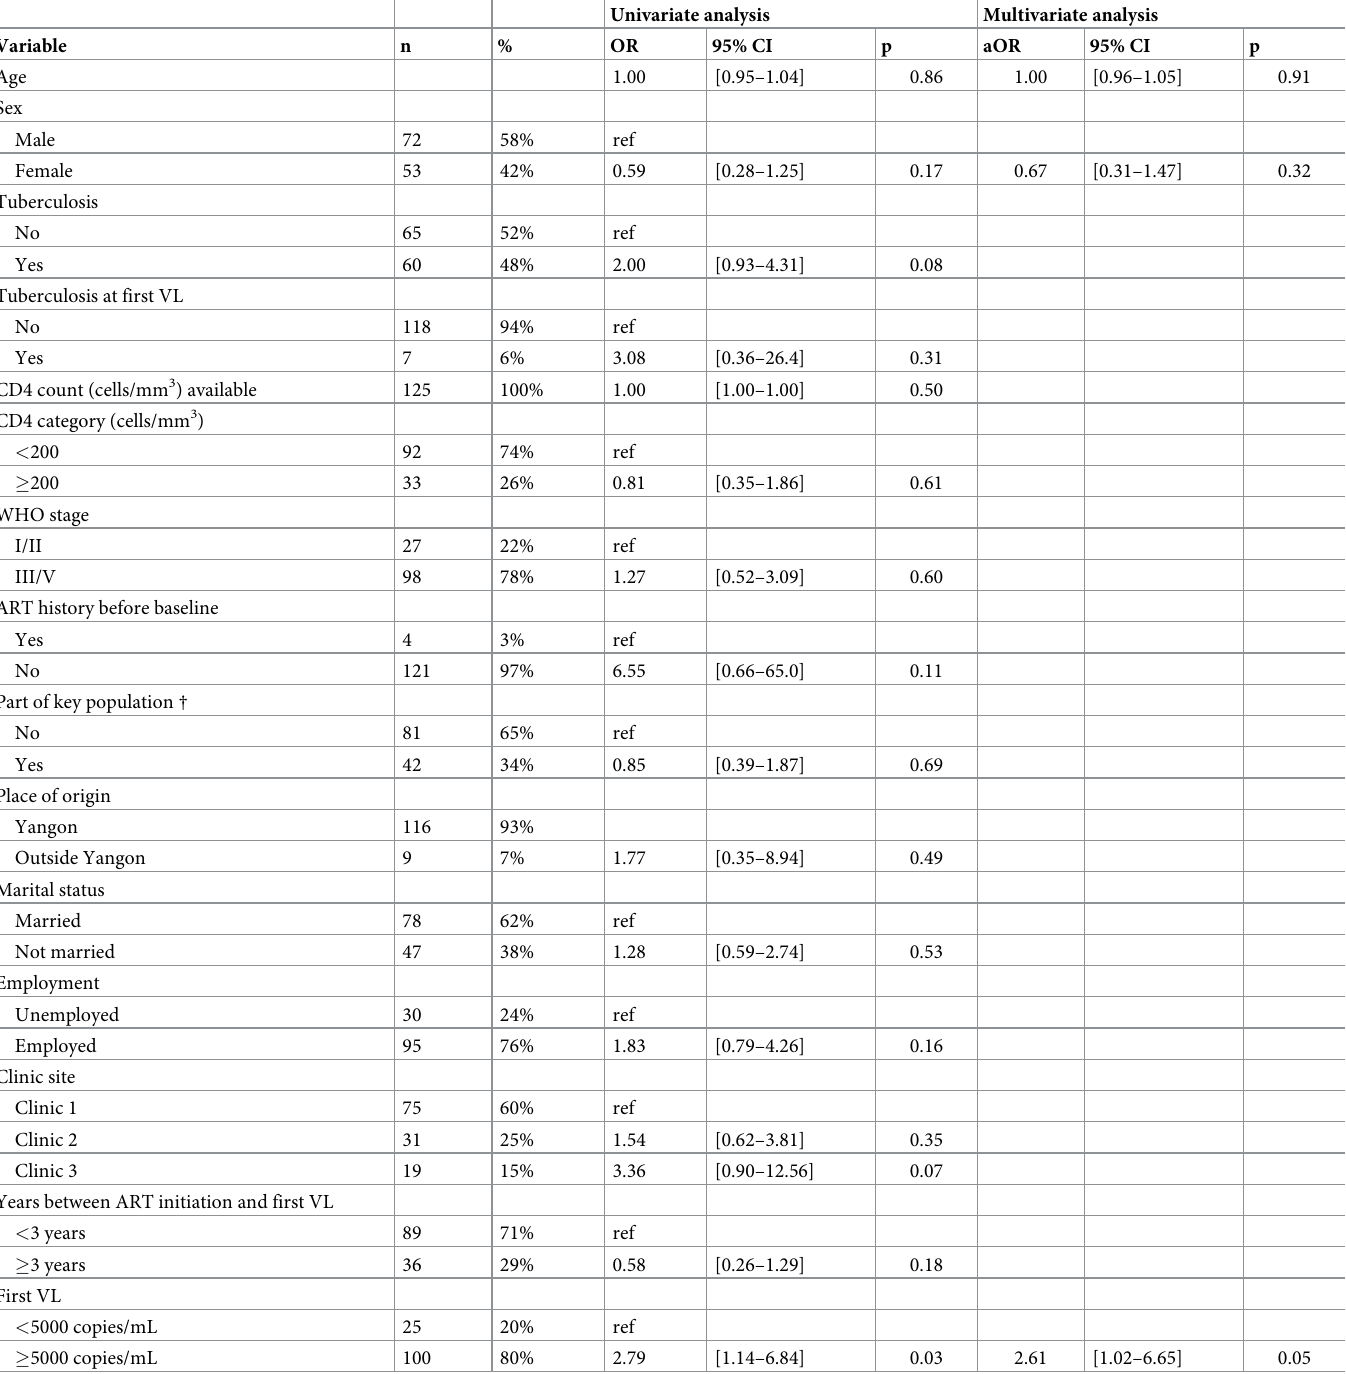
Table 3. Factors associated with confirmed virological failure in ART patients with enhanced adherence counselling after a first high near POC VL in Yangon,